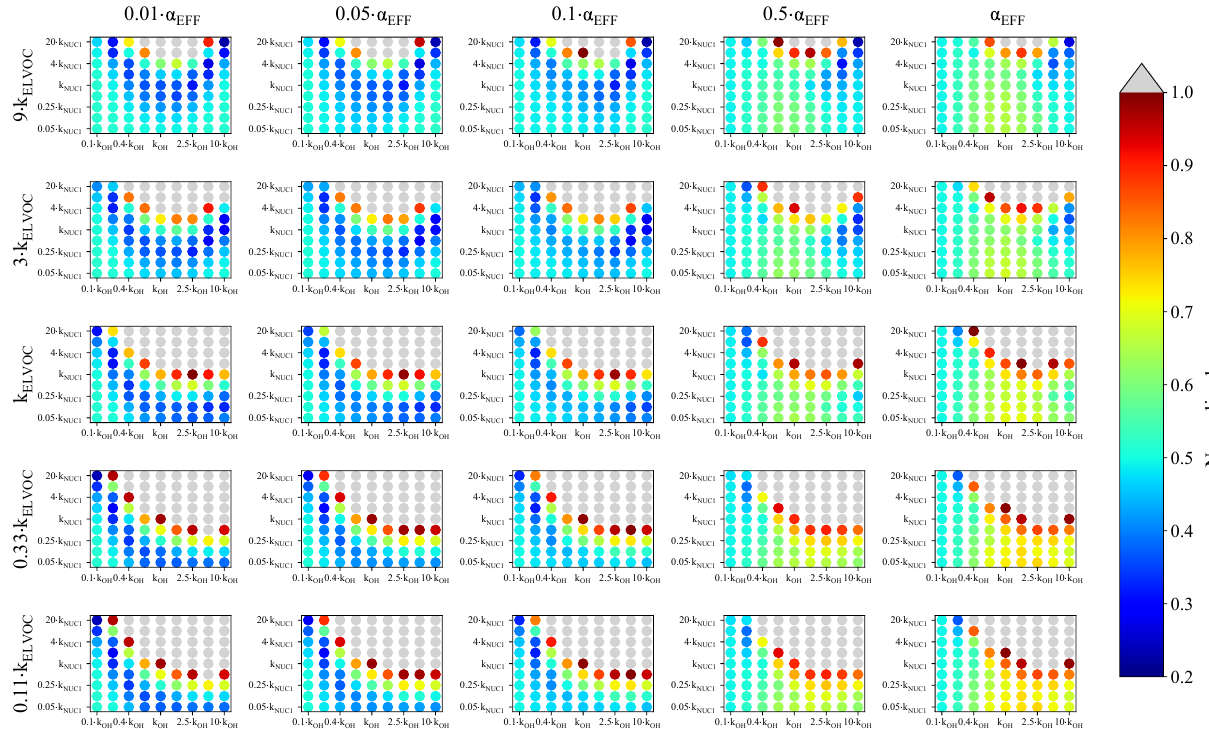
Figure 6. Representation of the parameter space for the average across the 0.3–0.6 day eq. aging exposures from GoAmazon examined in this study for the NUC1 nucleation scheme, base value of the reactive uptake coefficient of 0.6, and assumed S/IVOC:MT ratio of 30 × that of the BEACHON-RoMBAS S/IVOC:MT ratio. The effective accommodation coefficient increases across each row of panels; the rate constant of gas-phase fragmentation increases up each column of panels. Within each panel, the rate constant of gas-phase reactions with OH increases along the x axis and the rate constant for nucleation increases along the y axis. The color bar indicates the normalized mean error (NME) value for each simulation, with the lowest values indicating the least error between model and measurement. Grey regions indicate regions within the parameter space whose NME value is greater than 1. No averaged case had a NME value less than 0.2 for the cases shown